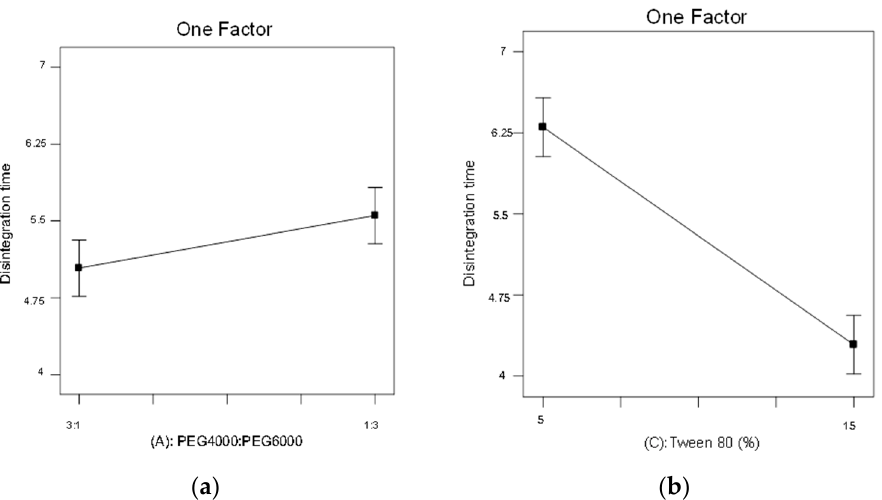
Figure 10. Using a 2 3 factorial experimental design to evaluate the effects of significant variables on disintegration time ( p < 0.05). ( a ) PEG 4000: PEG 6000 (factor A), ( b ) percentage of Tween 80 (factor